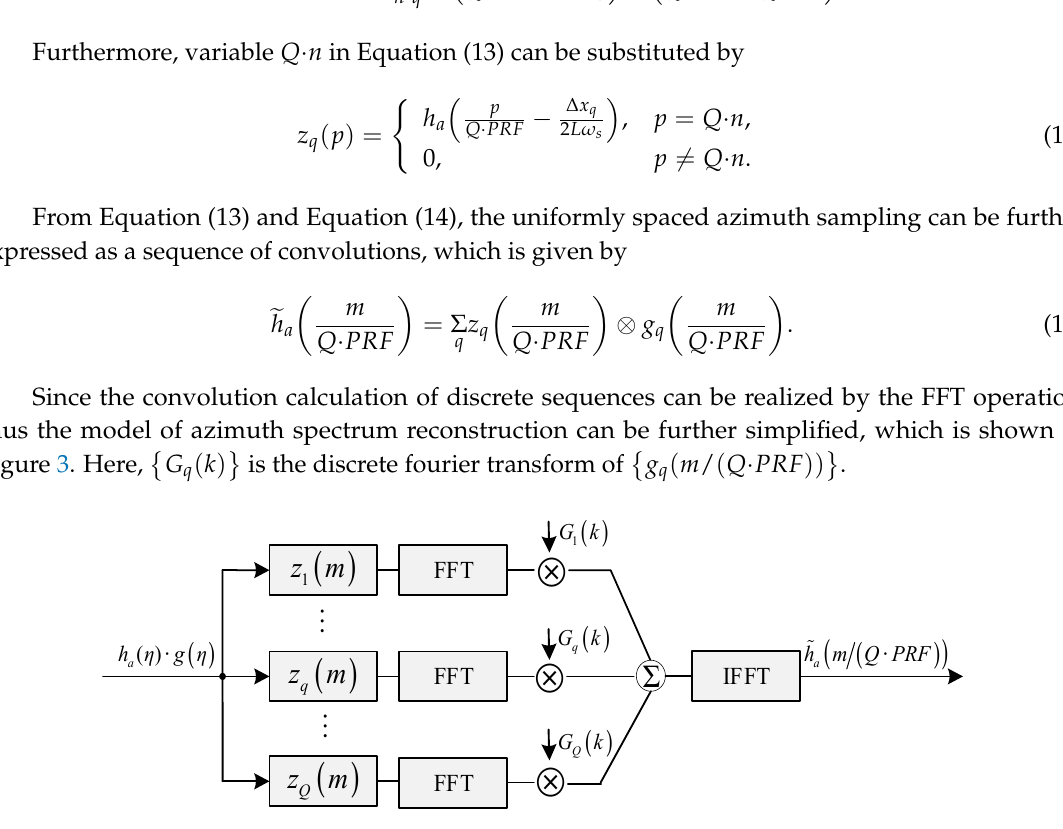
Figure 3. SAR spectrum reconstruction for azimuth multichannel non-uniform sampling.